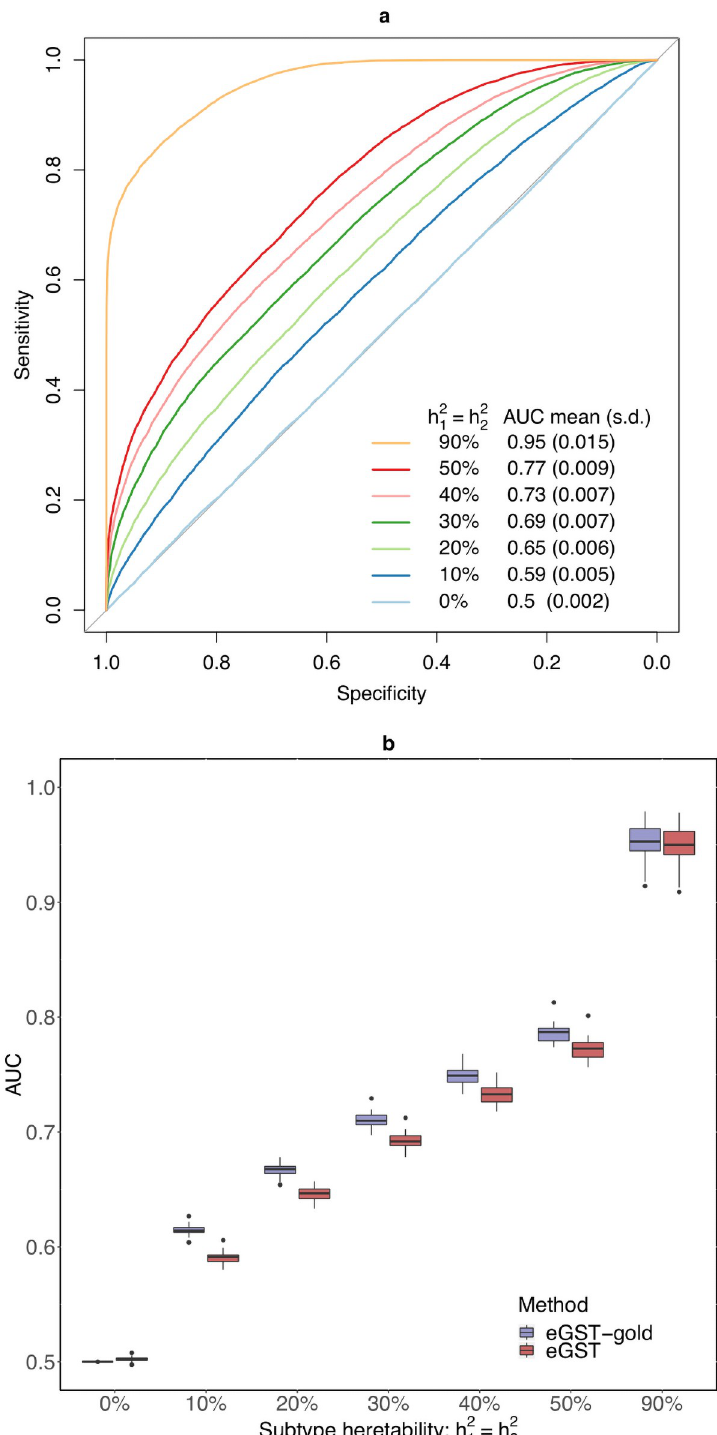
Fig 2. In the first diagram (a), we present the receiver operating characteristic (ROC) curve evaluating the classification accuracy of eGST for a single dataset simulated under the following scenarios: and h 2 are the heritability of tissue-specific subtypes of the trait due to m 1 and m 2 SNPs representing two sets of 2